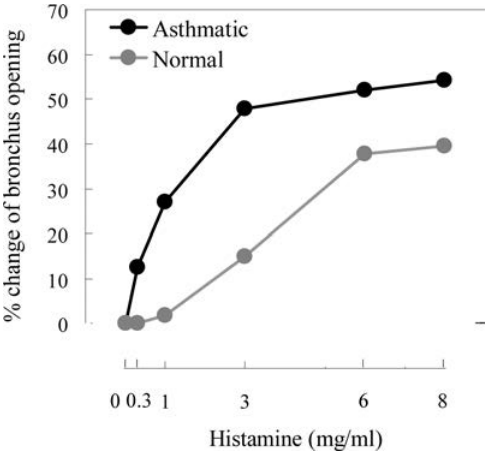
Fig. 7. Percentage of change in area of bronchus opening in response to histamine challenge for the normal and asthmatic